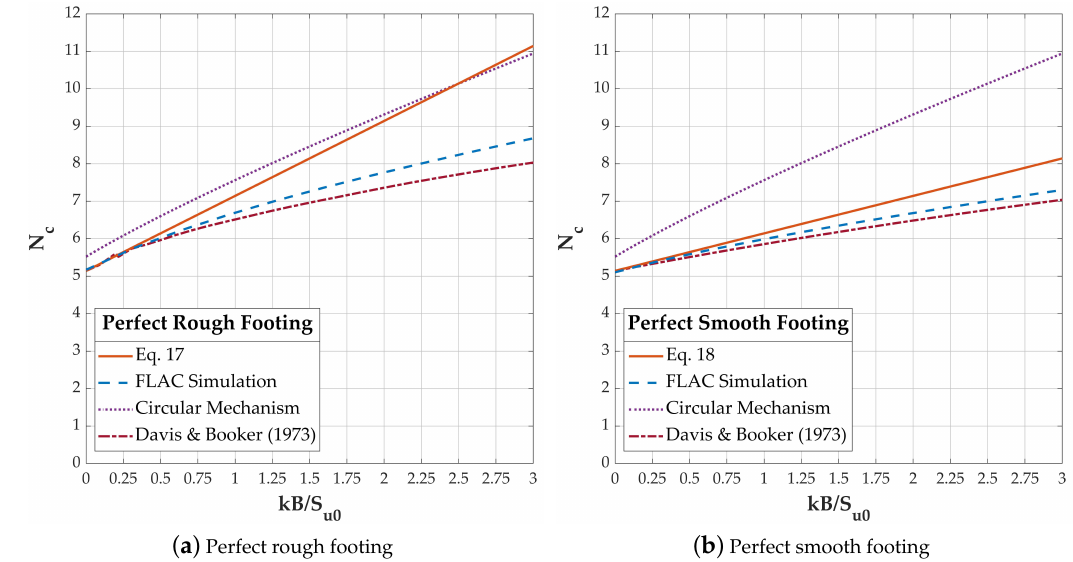
Figure 10. Roughness effect to bearing capacity factor N c